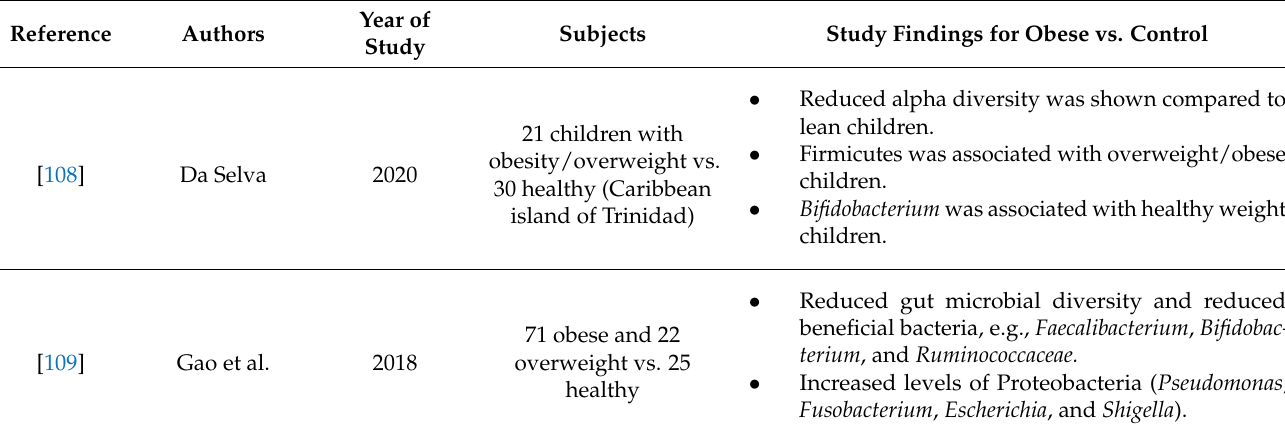
Table 6. Human studies of the gut microbiota in